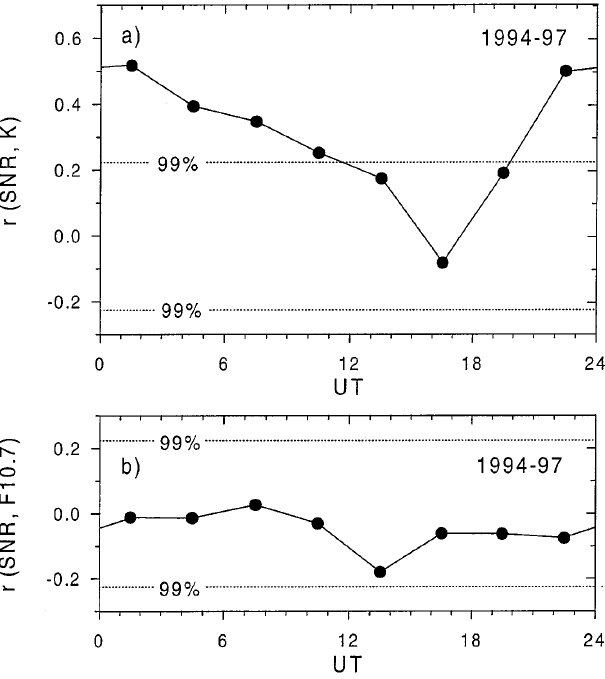
Fig. 3a, b. Diurnal variation of correlation coe(cid:129)cients between a SNR (83.0–87.5 km, Andenes) and geomagnetic K values and b between SNR and solar activity indices F10.7 using data for June and July 1994–1997. The dotted lines mark 99%